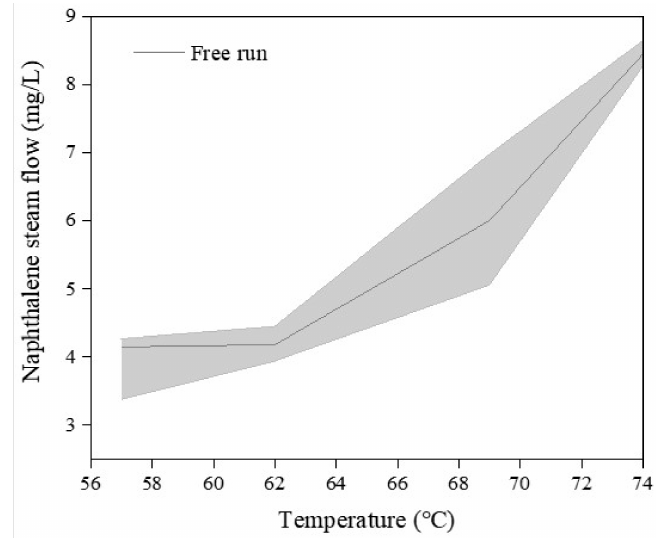
Figure 6. Naphthalene vapor fluxes under various heating temperatures.